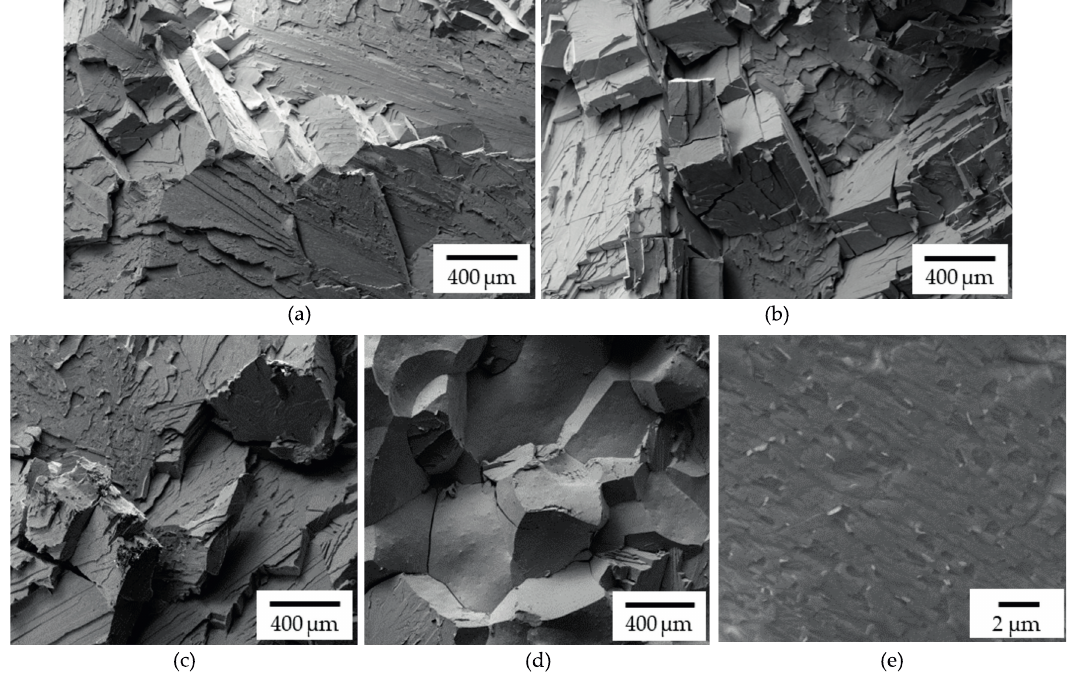
Figure 9. Tensile sample fracture surface of W-concept in solution annealed state ( a ) and aged at 650°C for 4h ( b ) as well as fracture surface of Mo-concept in solution annealed state ( c ) and aged at 650°C for 4h ( d , e